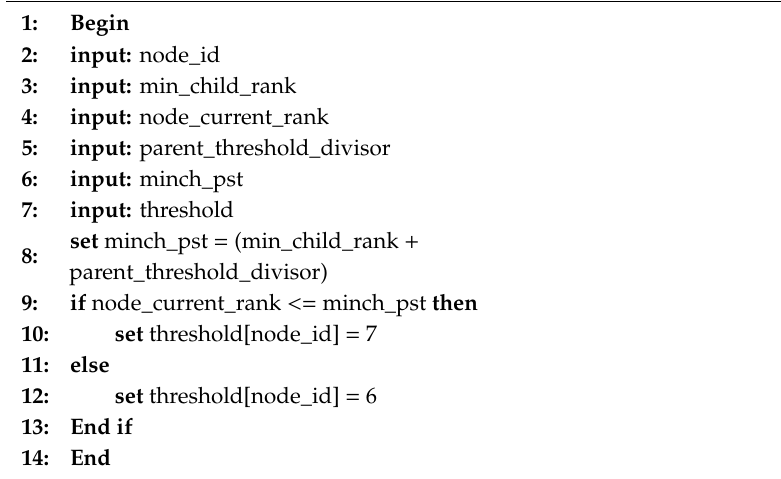
Algorithm A2. Evaluation of Node Current’s Rank and Node Child’s